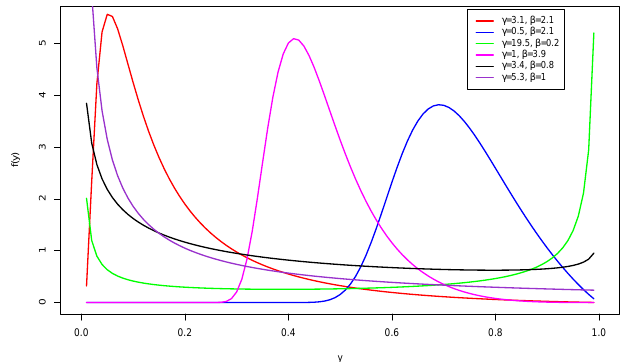
Figure 2. PDF plots of the CUGHN